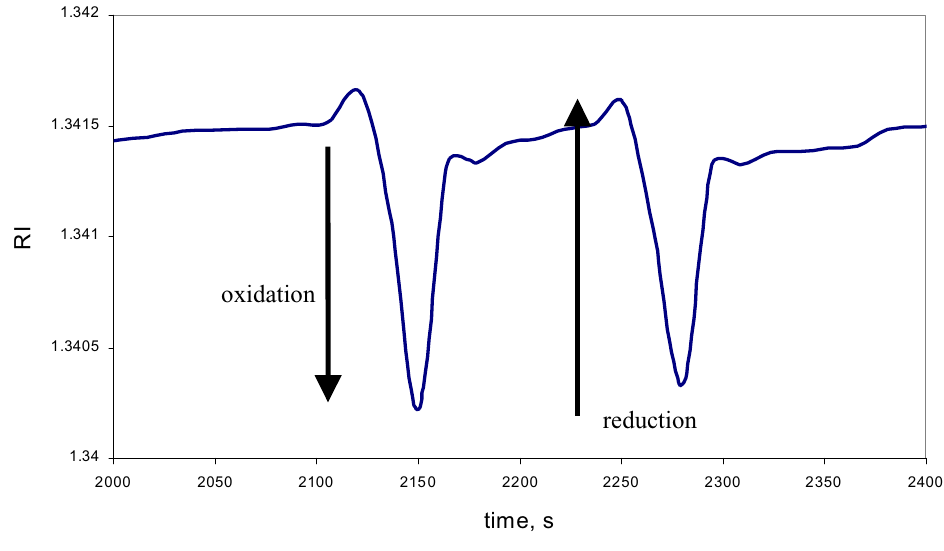
Figure 4. Changes in refractive index with time as measured by SPR during the oxidation